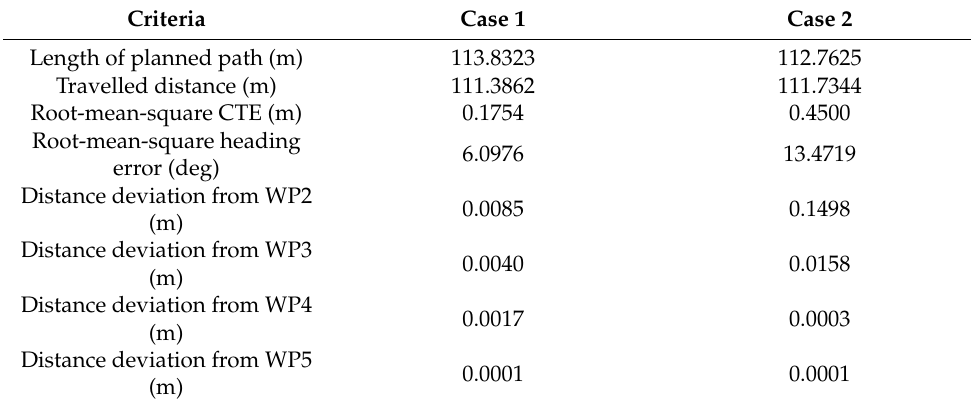
Figure 11. Simulated result of path follower: the traveled path and the corresponding curvature plot in case 1 ( a , b ) and case 2 ( c , d ). Table 4. Quantitative evalution in control and guidance performance for two